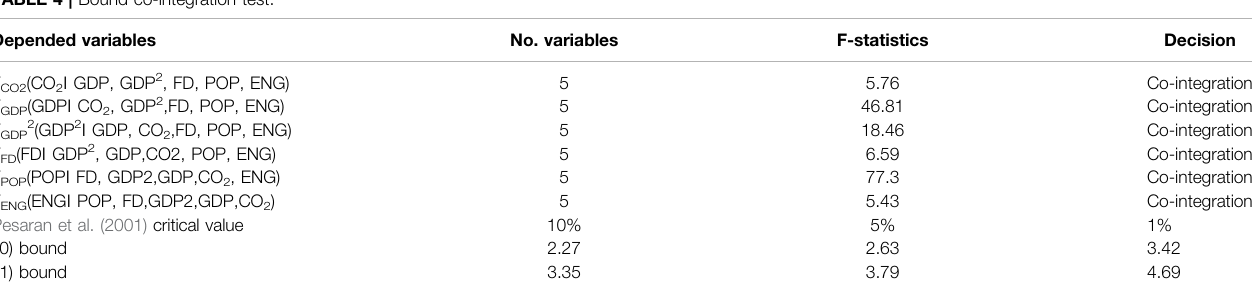
TABLE 4 | Bound co-integration test.